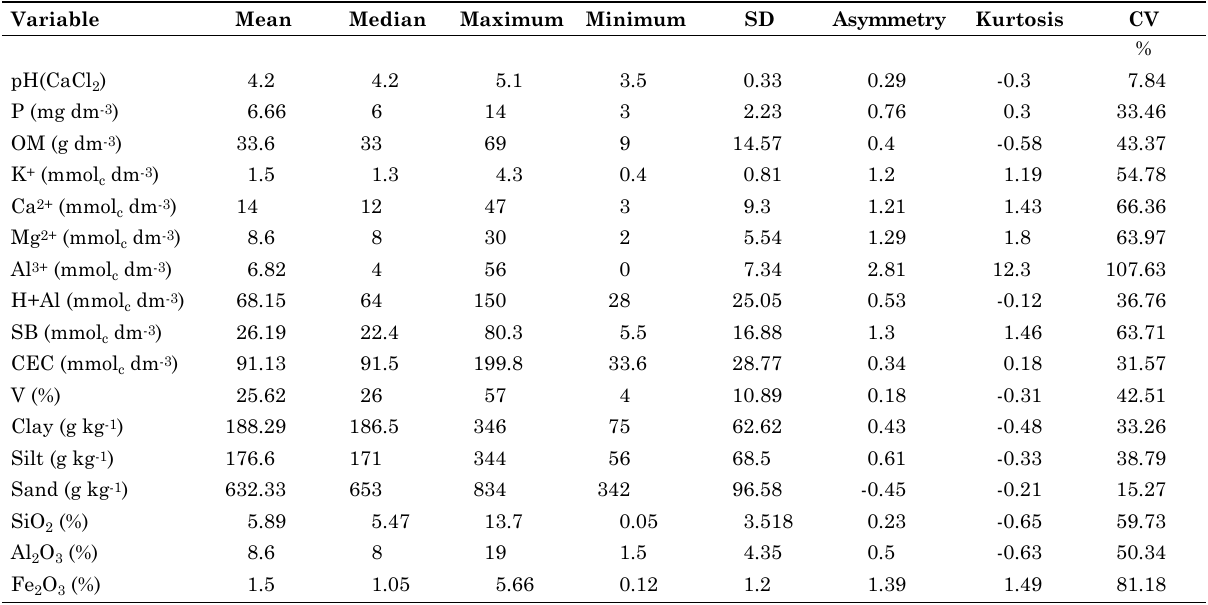
table 1. Descriptive statistics of the chemical and particle size variables studied in the agrarian reform settlement Variable